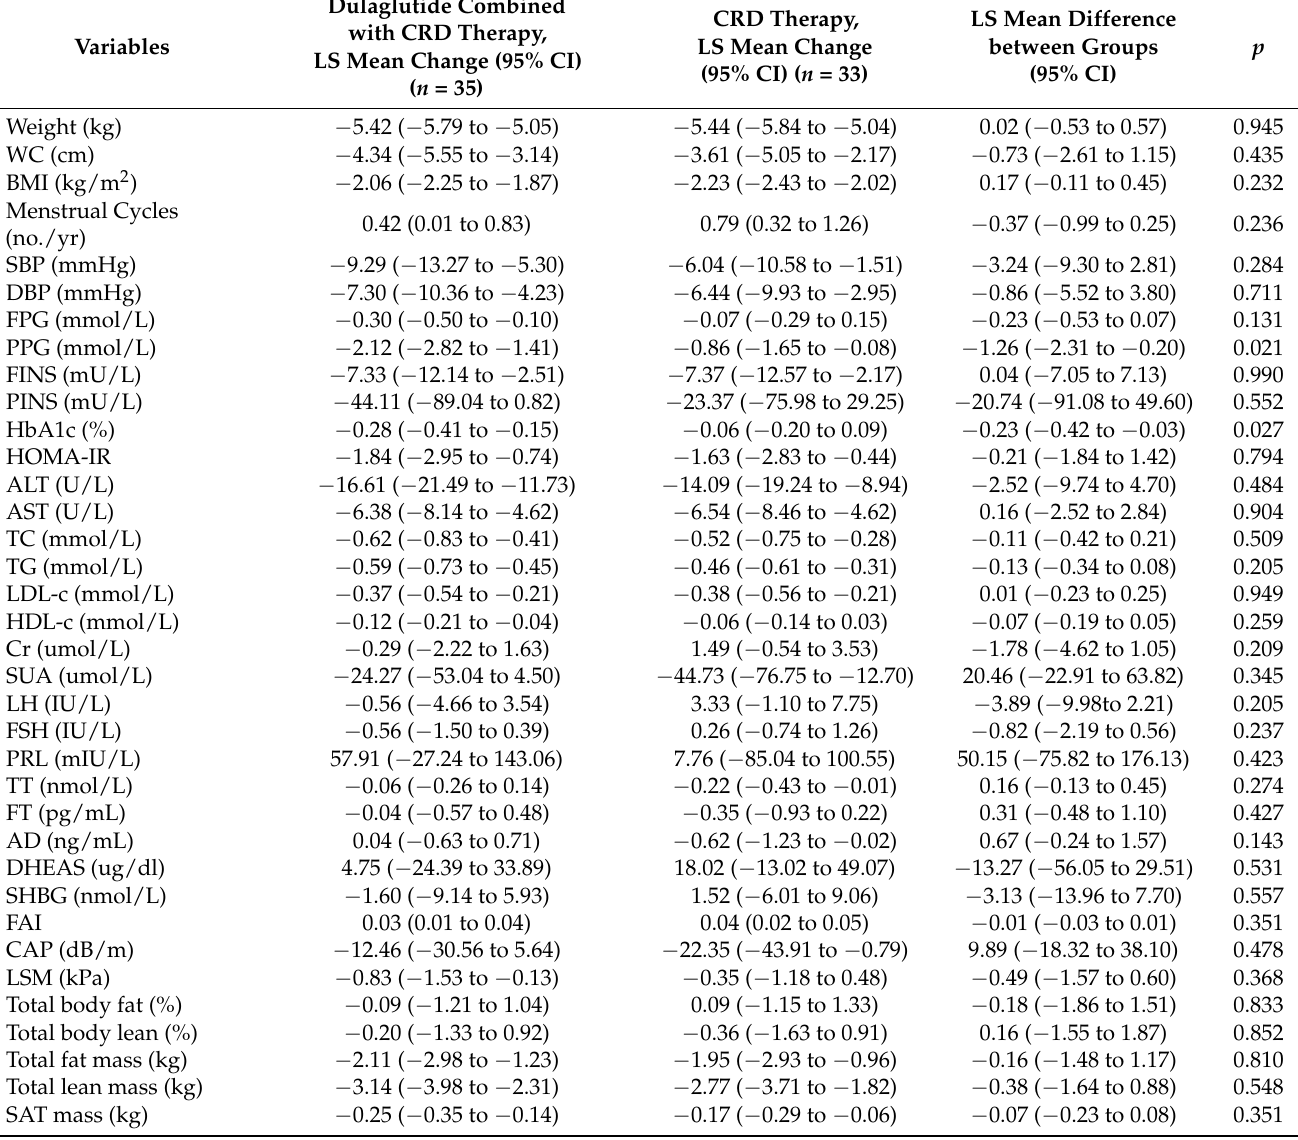
Table 2. Secondary efficacy